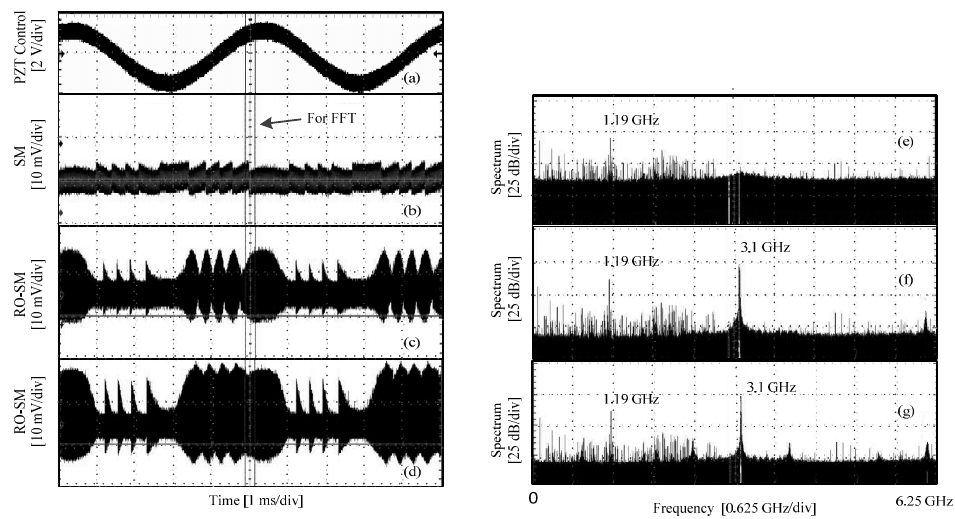
Figure 5. Experimental signals and their spectra in stable and semi-stable region. ( a ) PZT control signal; ( b ) conventional SM signals at stable region; ( c , d ) RO-SM signals at semi-stable region; ( e – g ) the spectra corresponding to ( b – d ) respectively.